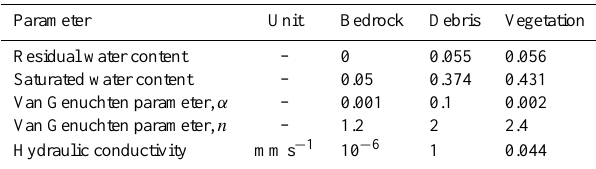
Table 1. Description of surface and sub-surface parameters used in this study. These are generic values of natural materials obtained from the literature. Parameter Unit Bedrock